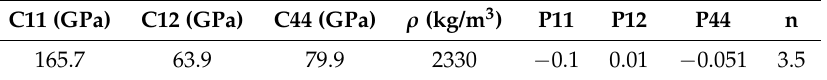
Table 3. Optical, elastic and photoelastic properties of